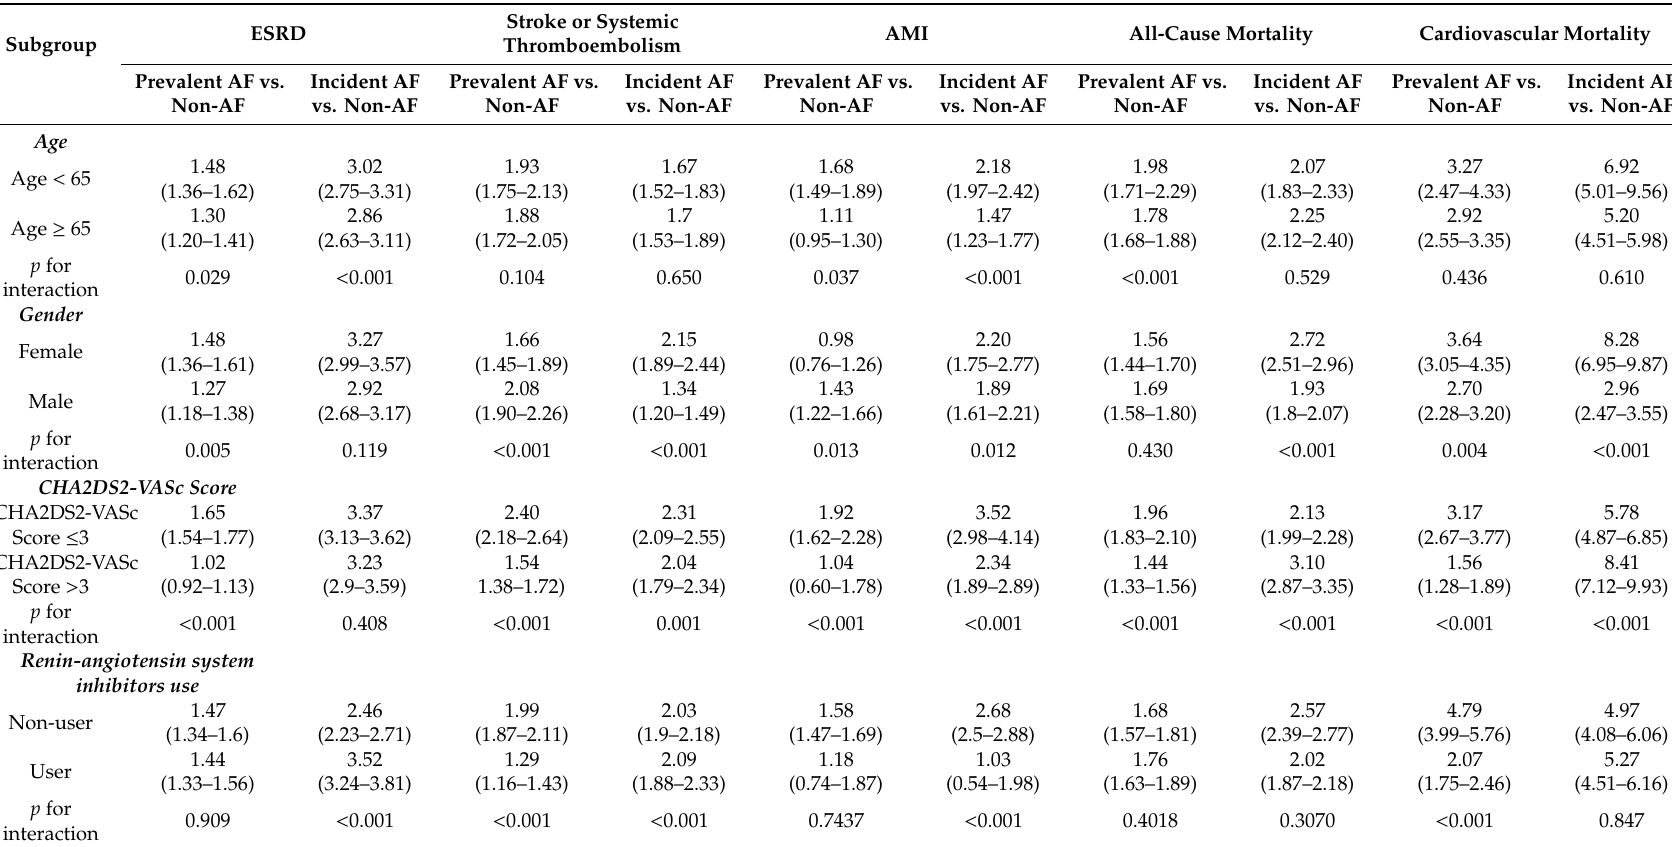
Table 3. Adjusted associations of AF status with risk of clinical outcomes stratified by sex, age, CHA2DS2-VASc score, and medication use. Stroke or Systemic ESRD AMI All-Cause Mortality Cardiovascular Mortality Subgroup Thromboembolism Prevalent AF vs. Incident AF Prevalent AF vs. Incident AF Prevalent AF vs. Incident AF Prevalent AF vs. Incident AF Prevalent AF vs. Incident AF Non-AF vs. Non-AF Non-AF vs. Non-AF Non-AF vs. Non-AF Non-AF vs. Non-AF Non-AF vs.